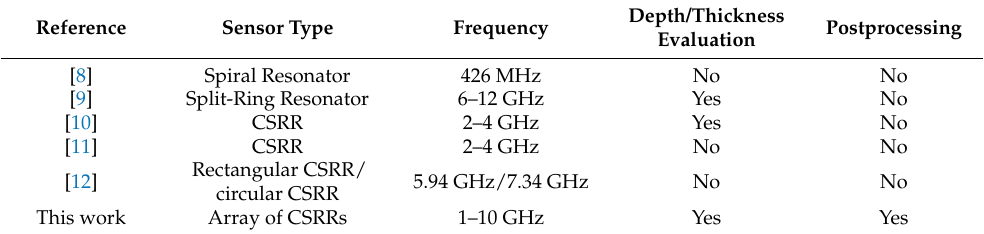
Table 1. Comparison of the proposed imaging system with those in the literature.